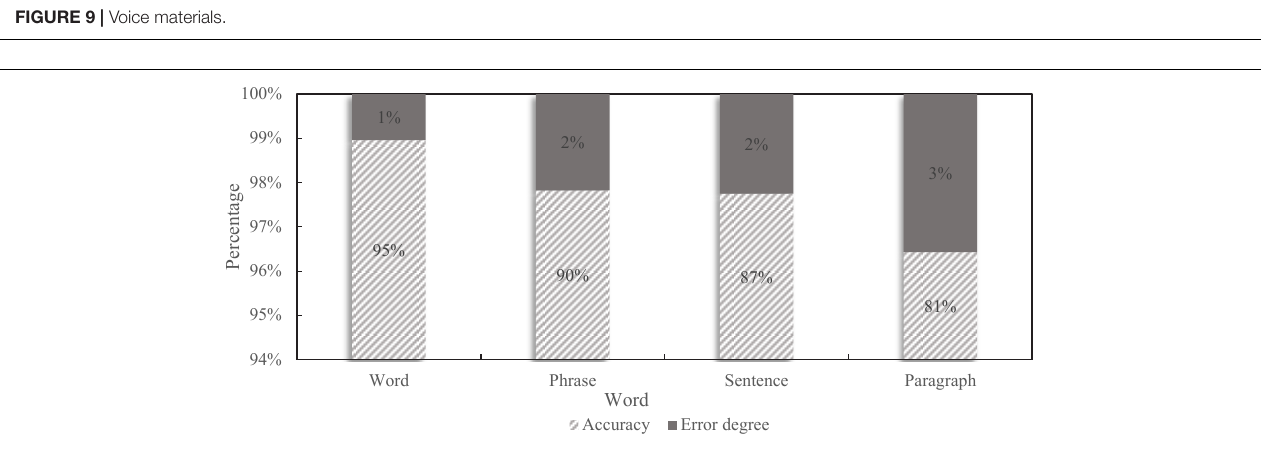
FIGURE 10 | Accuracy and error rate